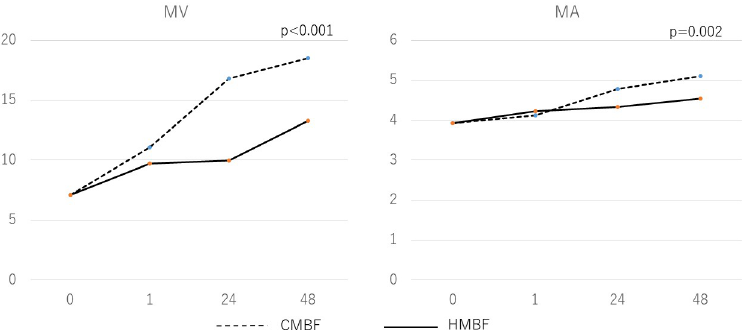
Fig 3. Particle size with time course. The diameter of MFG particles increased over time in donor human milk fortified with either cow milk-based fortifier (CMBF) or human milk-based fortifier (HMBF), with larger MFG particle sizes found in milk with CMBF. There were significant differences over time from baseline to 48 hours in mean diameter of the volume distribution (MV) and mean diameter of the area distribution (MA) (p < 0.001 and p = 0.002, respectively) between CMBF and